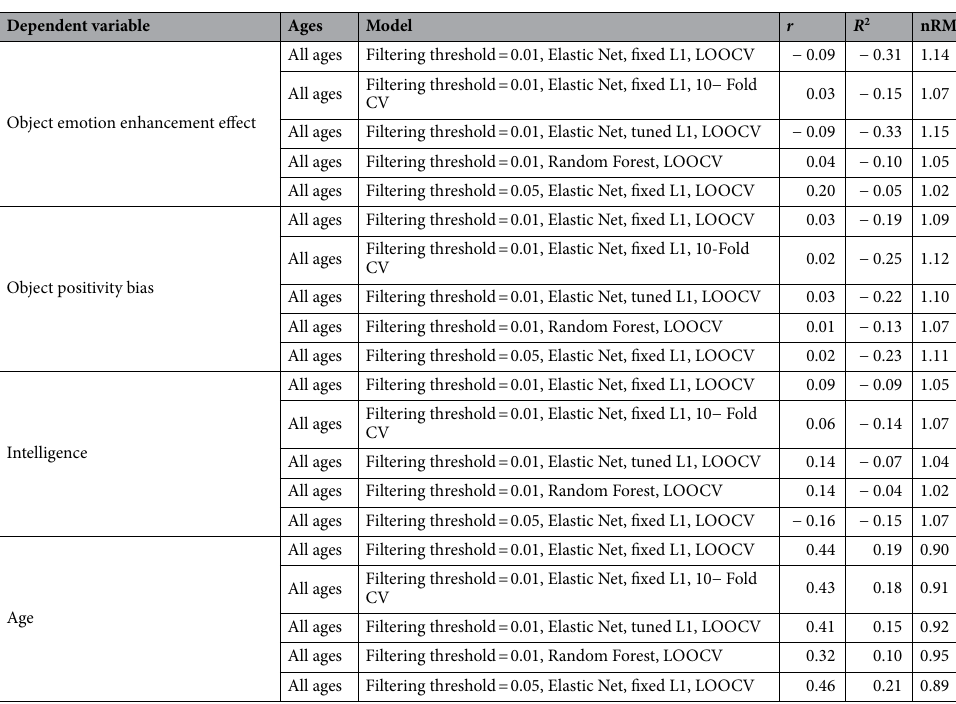
Table 6. Prediction results of alternative models. Fixed L1 is ridge-lasso ratio = 0.01. Tuned L1 refers to the procedures where L1 was chosen using a threefold nested cross-validation from the values: 0.1, 0.5, 0.7, 0.9, 0.99, 1. LOOCV refers to leave one-out cross validation. Random forest models tune the maximum depth parameter from the 5 values: 5, 10, 20, 40, 50, using a nested threefold nested cross-validation. Filtering threshold refers to the maximum p value of the correlation between individual edges and the predicted variable that was required for edges to be included in the prediction analysis.